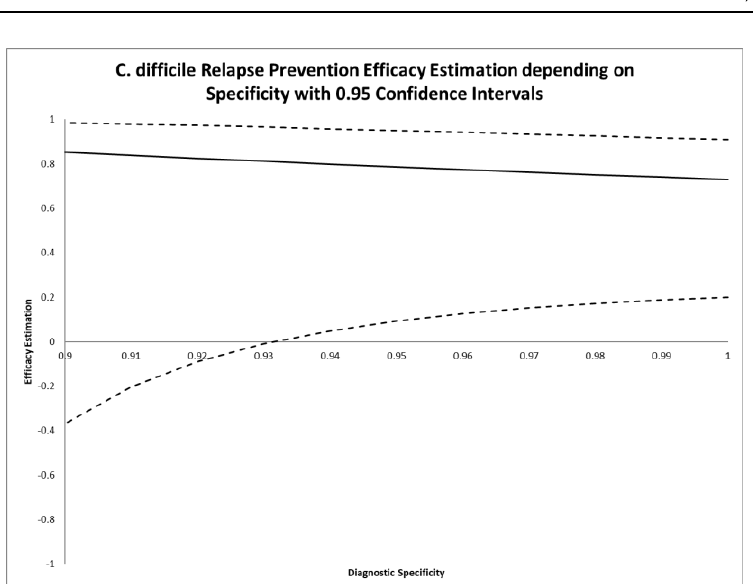
Figure 2. Adjusted efficacy estimates ( y -axis) depending on endpoint specificity ( x -axis) applying equation (7) with 0.95 confidence intervals and using equation (9) for the primary endpoint of the study by van Nood and colleagues on the effects of fecal transplantation for the treatment of recurrent Clostridium difficile infections. Table 2. Clostridium difficile relapse prevention efficacy estimates depending on specificity assumptions using equations (7) and